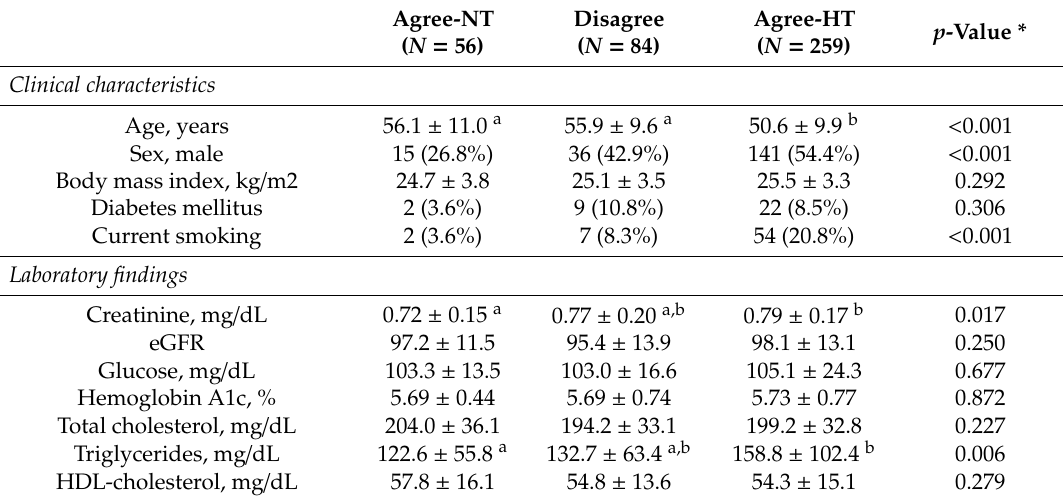
Table 1. Baseline clinical characteristics of the study